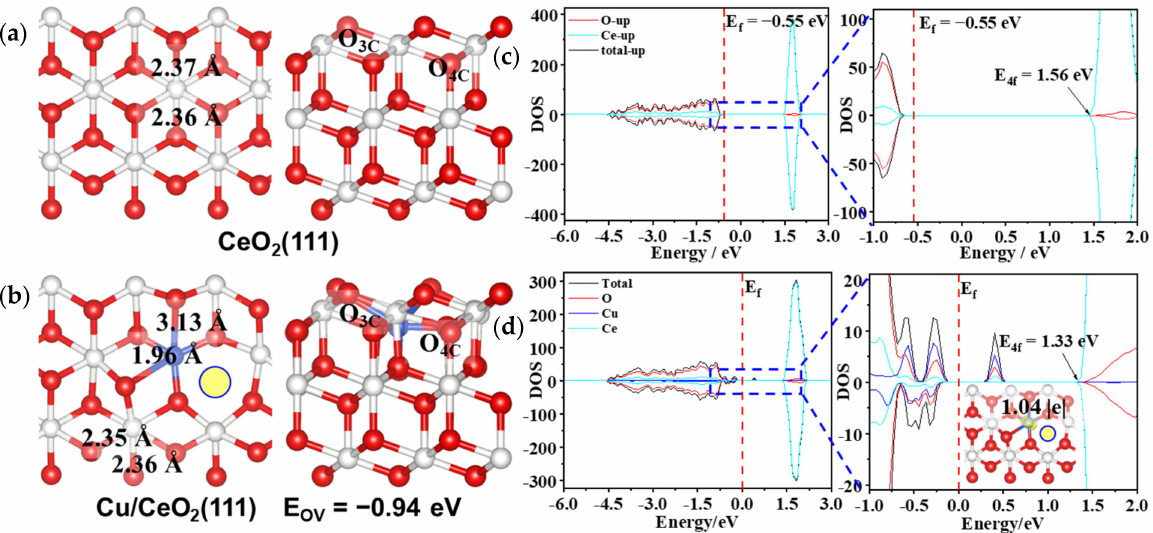
Figure 1. Calculated structures (left: top view; right: side view) of the ( a ) CeO 2 (111) and ( b ) Cu/CeO 2 (111) surfaces, and calculated density of states (DOS) of the ( c ) CeO 2 (111) and ( d ) Cu/CeO 2 (111) surfaces. The blue circles filled with yellow represent the inherent surface oxygen vacancy on the Cu/CeO 2 (111). Red: O atoms; ivory: Ce atoms; blue: Cu atoms. These notations are used throughout the paper. All DOS were aligned with respect to the O 2 s orbital of a fixed bottom O atom of the surface